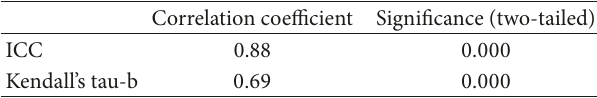
Table 1: Kendall’s tau-b and ICC ∗ correlations between the BAARS- IV and CAARS-S: